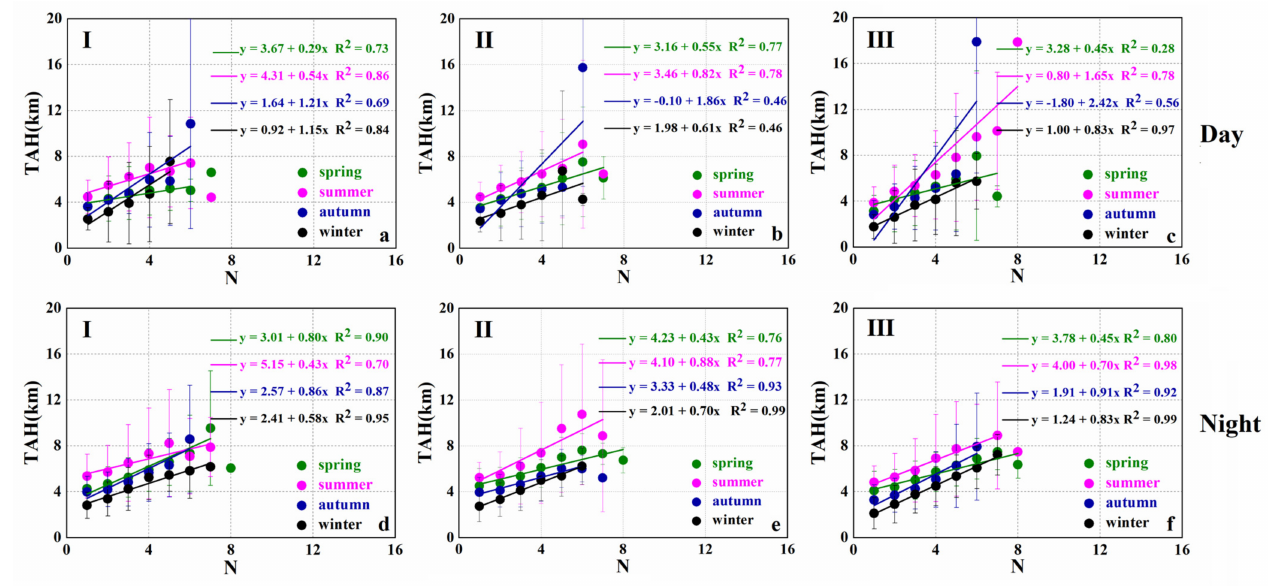
Figure 18. The correlation between TAH and N over Saudi Arabiafrom 2007 to 2019. ( a , d ) represent regions I, ( b , e ) represent regions II, and ( c , f ) represent regions III.